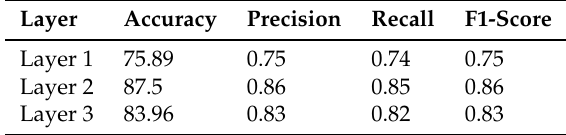
Table 9. Long Short-Term Memory (LSTM) Results—-Physionet.